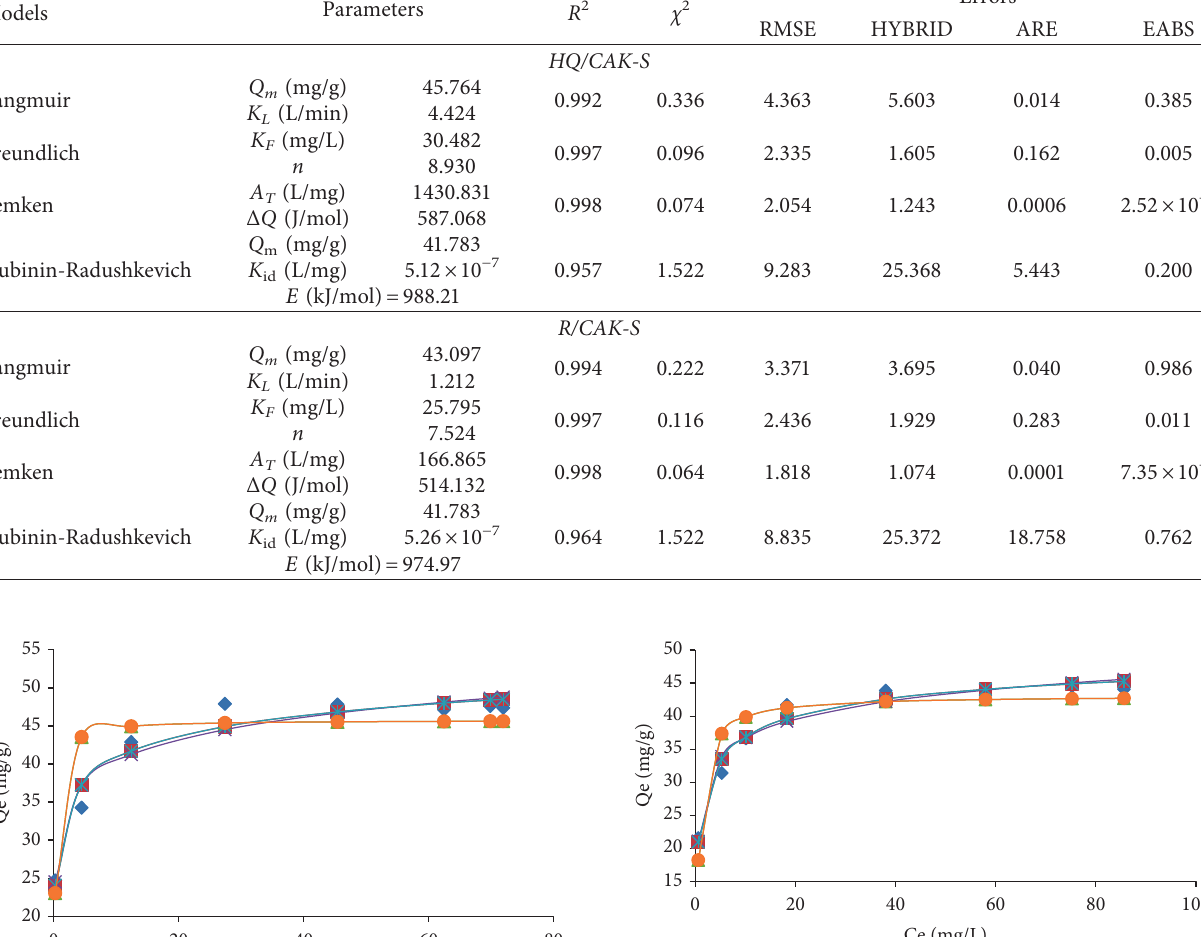
Table 9: Adsorption of hydroquinone and resorcinol: nonlinear fitting analysis for two-parameter isotherms (see equations in Tables 3 and 4). Models